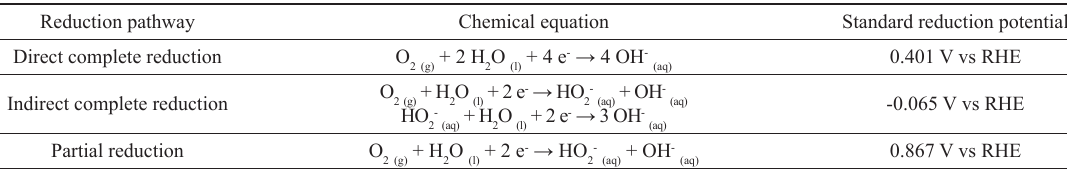
Table 1. Oxygen reduction pathways in alkaline